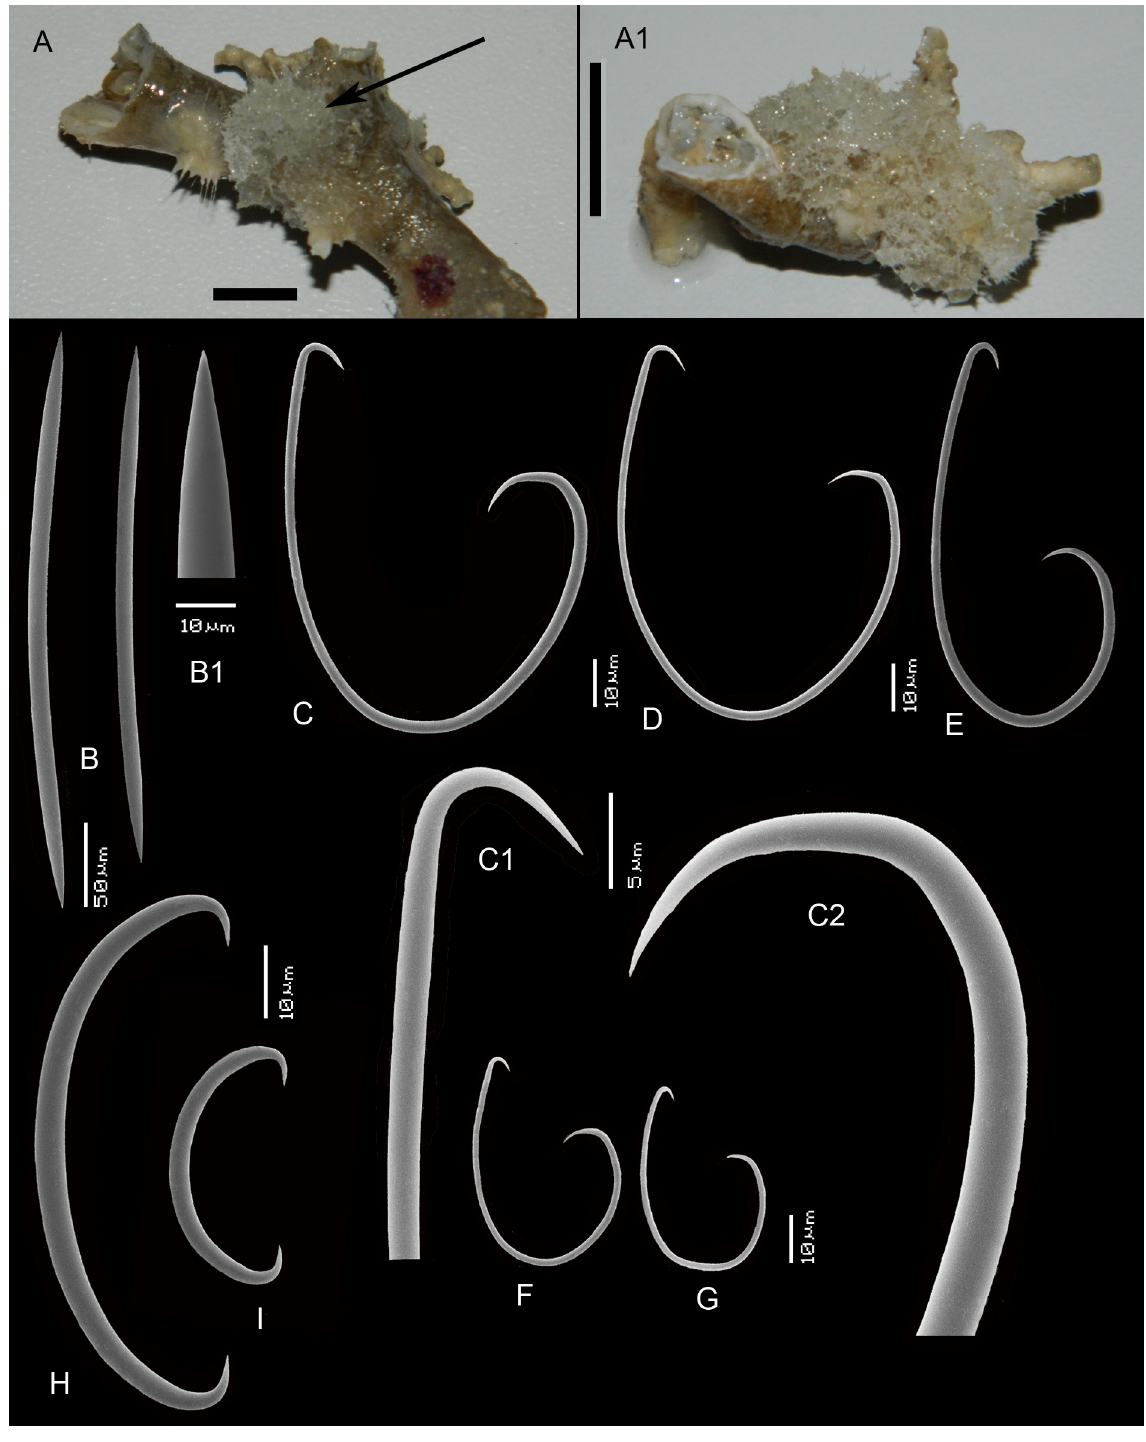
Fig. 14. Haliclona ( Flagellia ) hiberniae subgen. et sp. nov., from the deep water of the Rockall Bank, W of Ireland. A . Habitus (arrow) of holotype (ZMA Por. 19596a), encrusting a dead coral. A (paratype ZMA Por. 19619), encrusting a hydrocoral. B–I . SEM images of the spicules. B . Oxeas. B Detail of one of the apices. C–E . Large category of flagellosigmas (I). C flagellosigma. C . Detail of short ending of large flagellosigma. F–G . Small category of flagellosigmas 2 (II). H . Large category of sigmas (I). I . Small category of sigmas